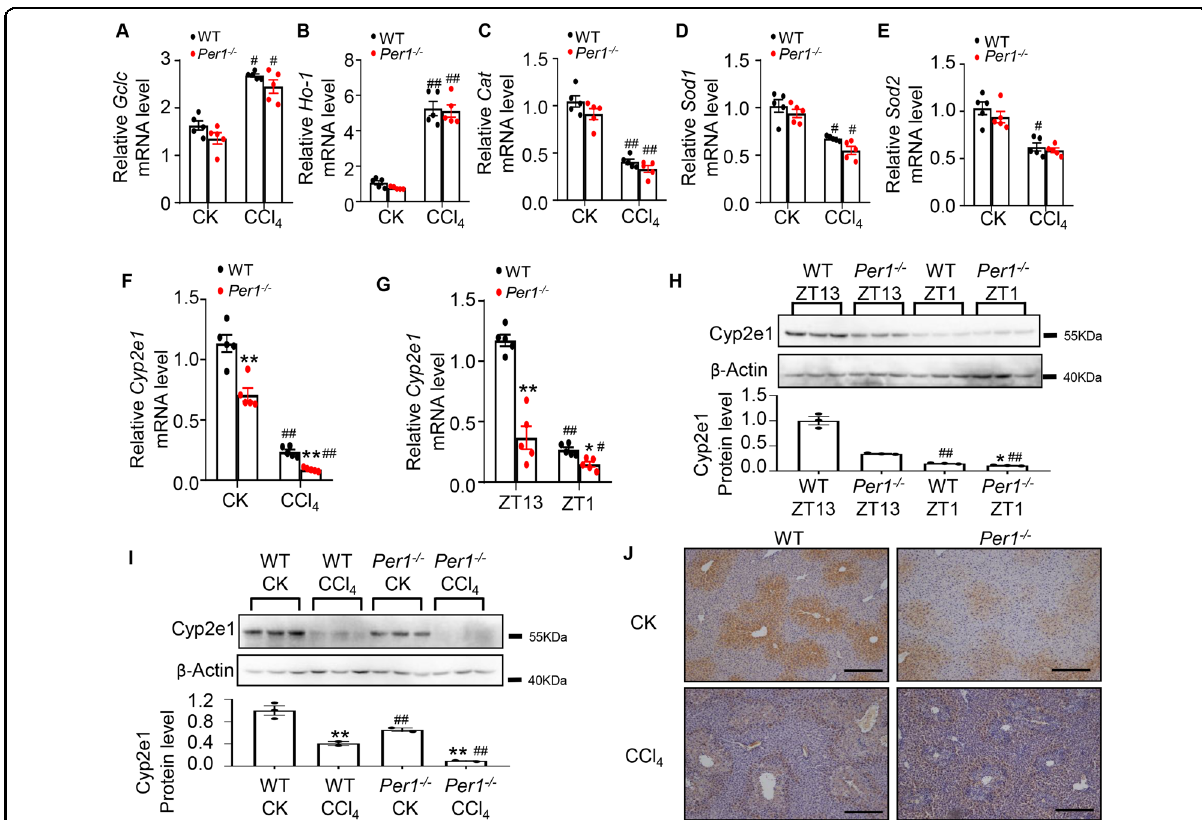
Fig. 5 Effect of Per1 de fi ciency on Cyp2e1 expression exposed to CCl4. Liver tissues were collected 24 h after single CCl 4 administration. Hepatic mRNA levels of A Gclc , B Ho-1 , C Cat , D Sod1 , E Sod2 , and F Cyp2e1 were measured by real-time PCR. CK: control. Data were shown as means ± S.E.M. N = 5 independent biological replicates per group. * indicates P value < 0.05, ** indicates P value <0.01, Per1 − / − group versus WT group; # indicates P value <0.05, ## indicates P value <0.01, CCl 4 group versus control group. G Cyp2e1 expression was measured by real-time PCR in the mouse liver at ZT1 and ZT13. H Representative western blots for rhythm of CYP2E1 protein expression in the mouse liver. Extracts were measured via western blot analysis with anti-CYP2E1 or anti – β -ACTIN antibody. CK: control. Data were shown as means ± S.E.M. N = 3 independent biological replicates per group. * indicates P value <0.05, ** indicates P value <0.01, Per1 − / − group versus WT group; # indicates P value <0.05, ## indicates P value <0.01, ZT1 group versus ZT13 group. I Western blot assay of CYP2E1 protein after CCl 4 treatment in vivo. J Representative images of immunohistochemical staining were shown for liver sections stained with anti-CYP2E1 antibody. This is in agreement with the RT-PCR and western blot data. Bar = 100 μ m. Representative images from N = 3 biological replicates. CK: control. Data were shown as means ± S.E.M. N = 3 independent biological replicates per group. * indicates P value <0.05, ** indicates P value <0.01, Per1 − / − group versus WT group; # indicates P value <0.05, ## indicates P value <0.01, CCl 4 group versus control group. Data represent cumulative results from three independent